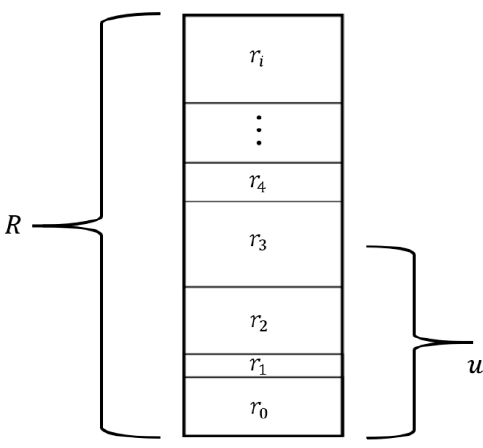
Figure 3. Method of selecting an event from the available list in the kMC algorithm.